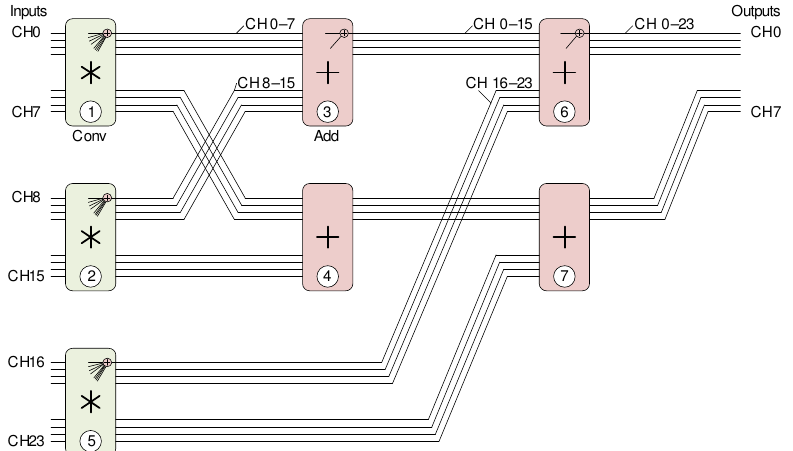
Figure 11. Core reconfiguration plan to process 24 inputs (channels CH0 to CH23) and obtain 8 output channels (CH0 to CH7). Green block—convolutional core, red block—same convolutional core configured for the sum